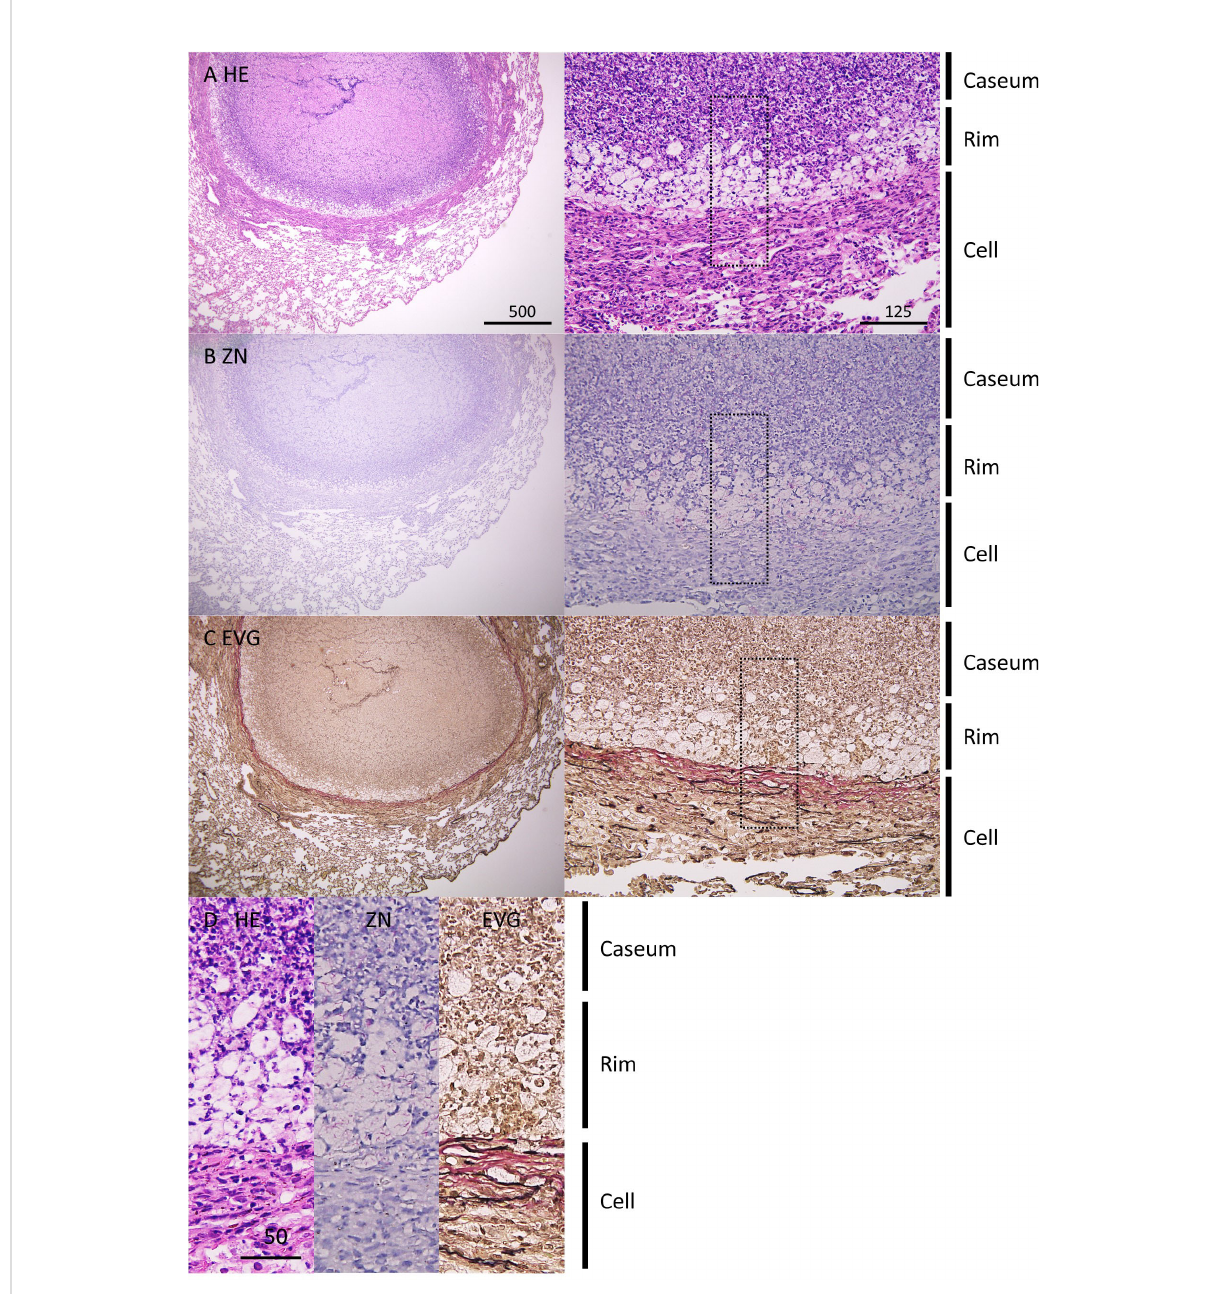
FIGURE 1 Pathological features of necrotic granulomatous lesions developed in lungs of M. tuberculosis -infected C3HeB/FeJ mice. (A – C) Infected lungs with necrotic granulomatous lesions at 8 weeks p.i. were stained with hematoxylin-eosin (HE) (A) and Ziehl-Neelsen (ZN) staining (B) . Elastica van Gieson (EVG) staining was carried out to visualize collagen (pink) and elastic (black) fi bers (C) . The right panels are enlarged images of the left panels. (D) Comparison of images with HE, ZN, and EVG staining of necrotic granulomas. The regions enclosed by the dotted lines in (A – C) were enlarged. The regions corresponding to necrotic caseum (Caseum), rim enriched foamy macrophages (Rim), and peripheral macrophages and lymphocytes (Cell) are